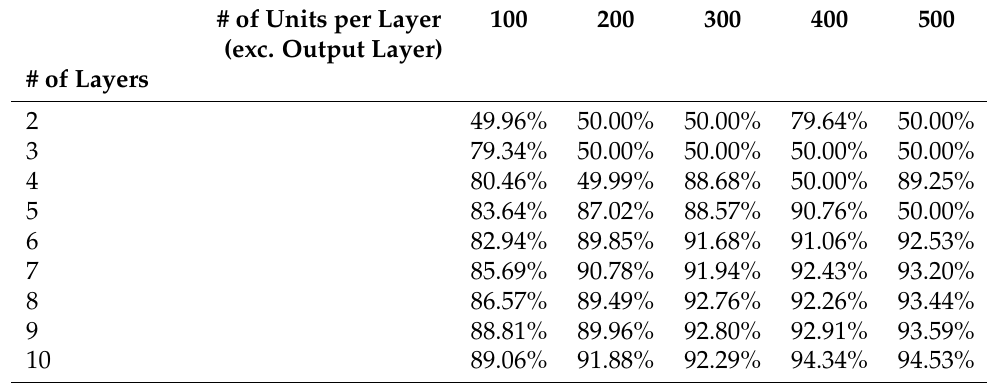
Table A2. AUC values for different number of layers and units per